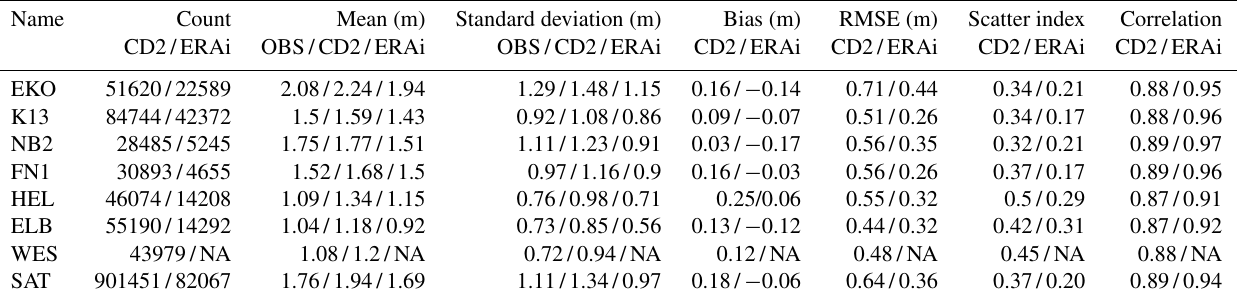
Table 2. Error metrics for the SWH at seven locations derived from in situ observations (OBS), coastDat2 hindcast (CD2) and ERA-Interim reanalysis (ERAi), for 1h (coastDat2) and 6h (ERA-Interim) data respectively.